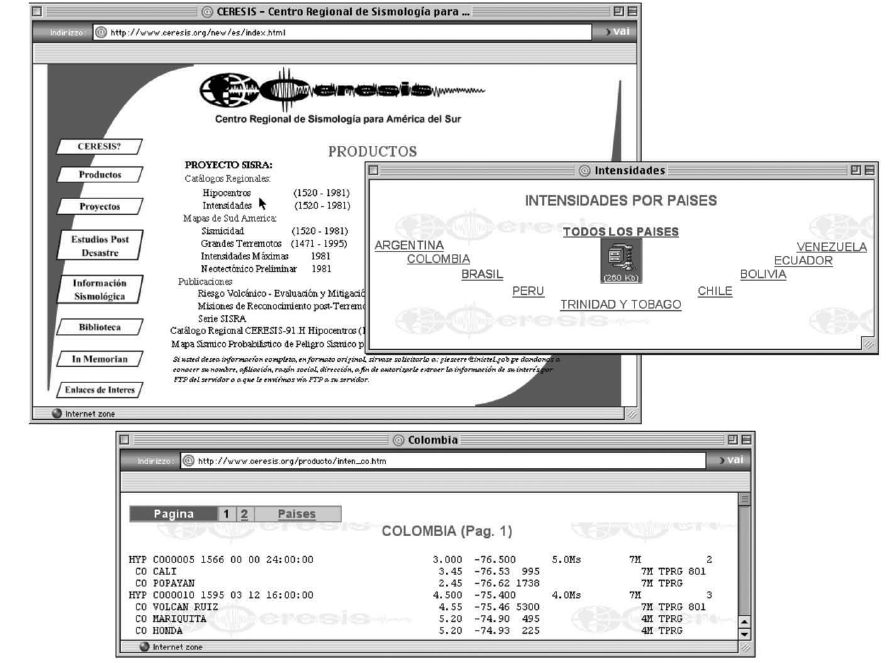
Fig. 6. CERESIS catalogue: entry point from the list of available countries, hypocentre parameters and IDPs for a selected